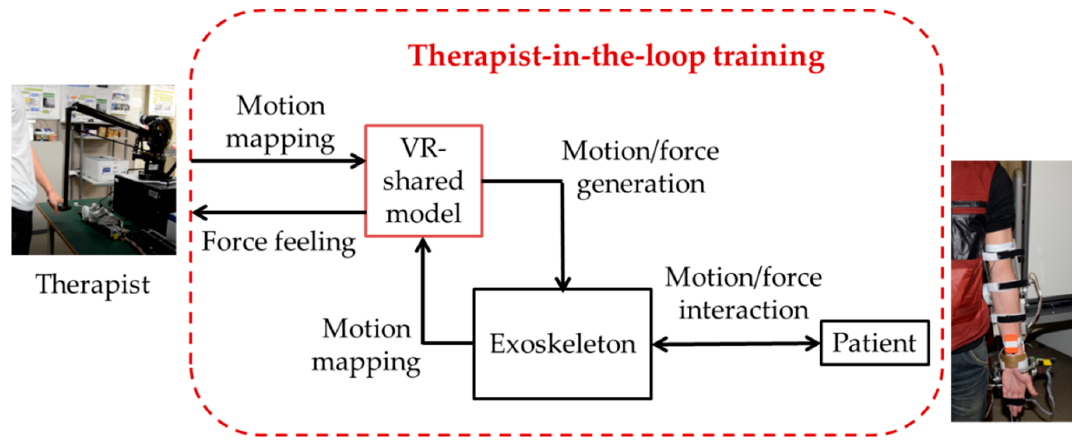
Figure 1. Schematic diagram of the rehabilitation platform.